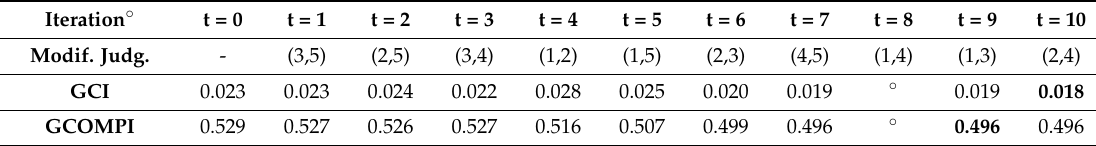
Table 7. Results for the iterative procedure with θ = 0.5 (the best value of the methods is in bold, for each indicator).